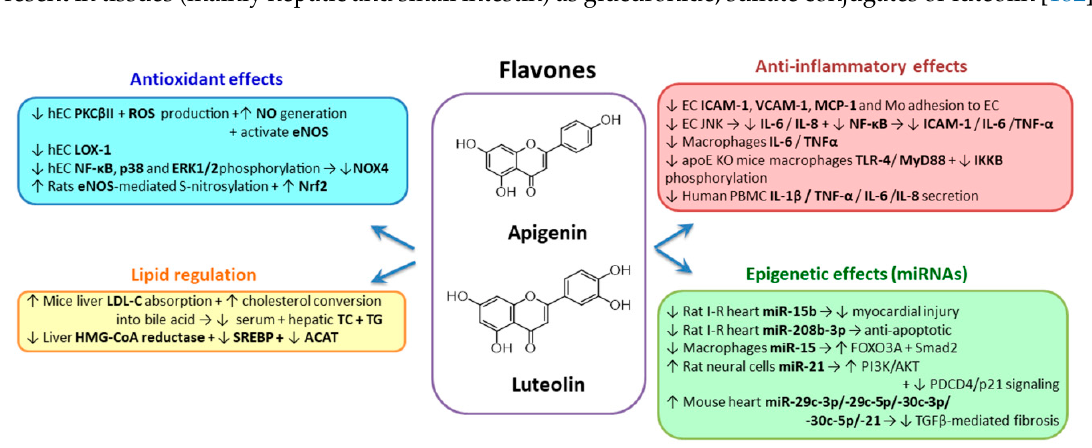
Figure 4. Antioxidant, anti-inflammatory, lipid-lowering and epigenetic mechanisms to improve cardiovascular diseases outcomes demonstrated by apigenin and luteolin.